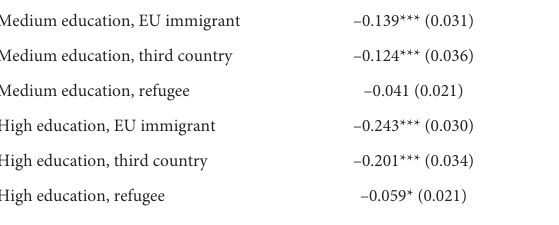
TABLE 4 Likelihood of welfare receipt of immigrants in Germany, marginal effects of interaction term between education level and immigrant group.